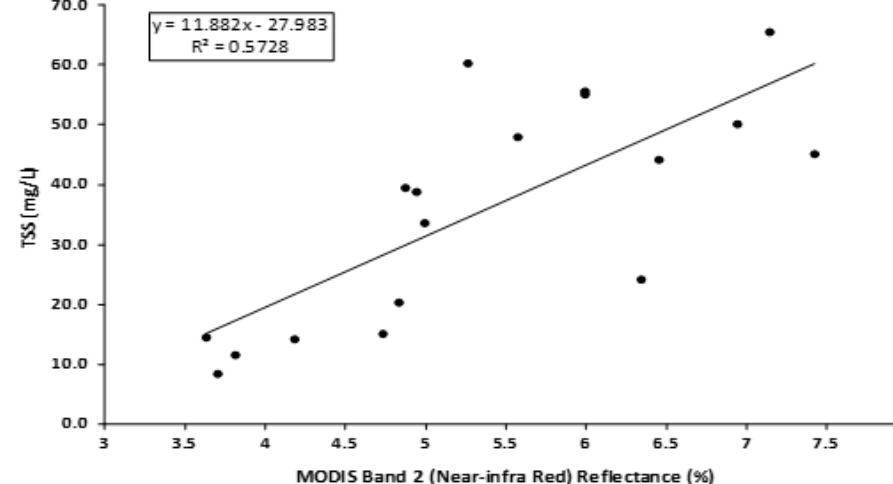
Figure 5. The correlation between MODIS Reflectance of NIR Band (Band 2) and TSS.